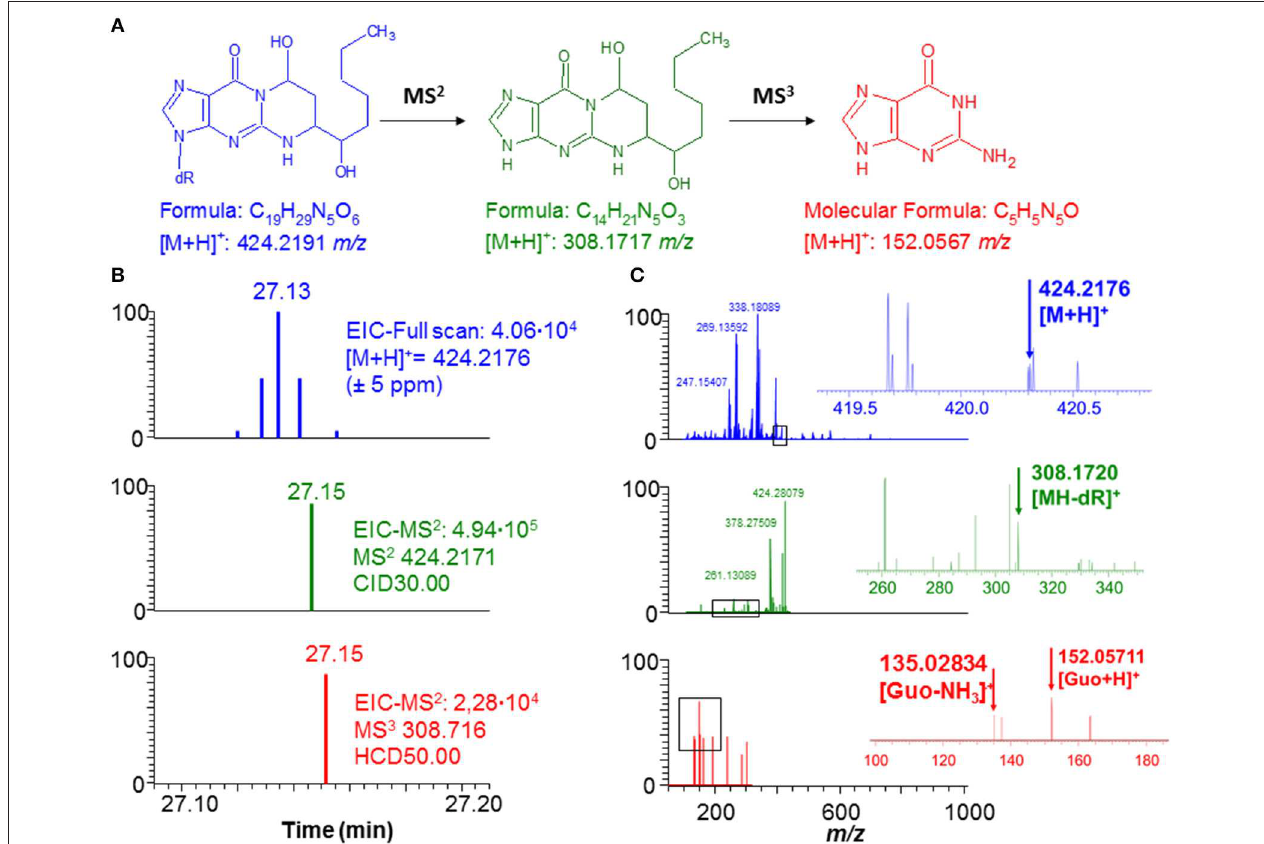
FIGURE 2 | Typical example of DNA adduct (HNE-dG) detected in a lung sample treated with LPS. (A) Fragmentation pathway of the DNA adduct (HNE-dG) ion. (B) The scan events corresponding to the full scan (blue), MS 2 (green), and MS 3 (red) spectra indicating the presence of the HNE-dG ion. (C) The spectra corresponding to the full scan (blue), MS 2 (green), MS 3 (red) scan events shown in (B)